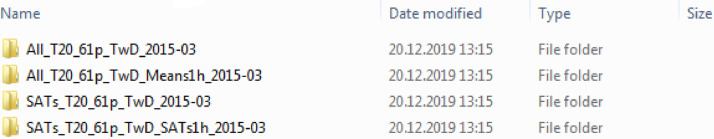
Organization of the processed data in corresponding folders.